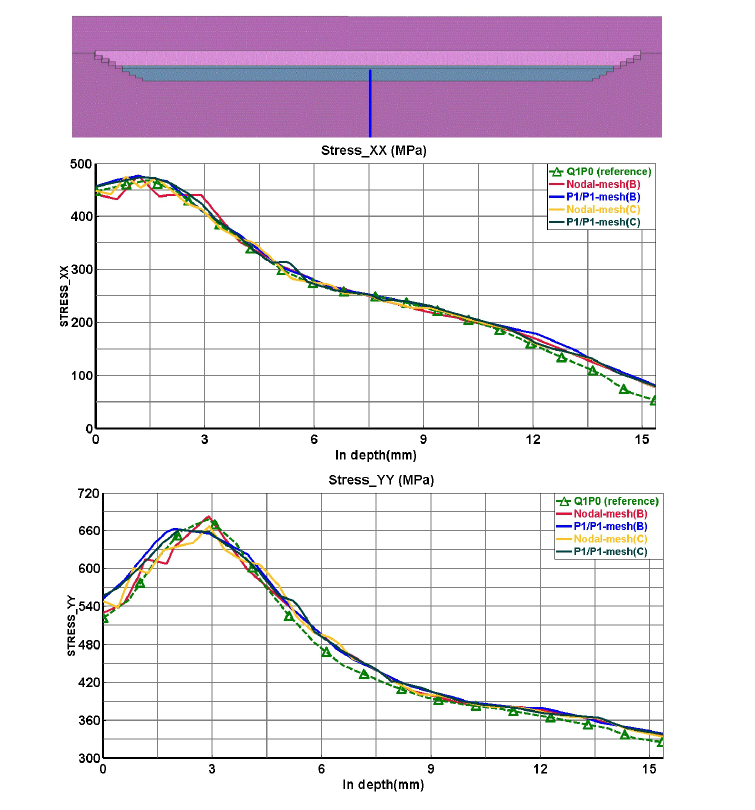
Figure 9. Comparison of residual stresses σ xx and σ yy in